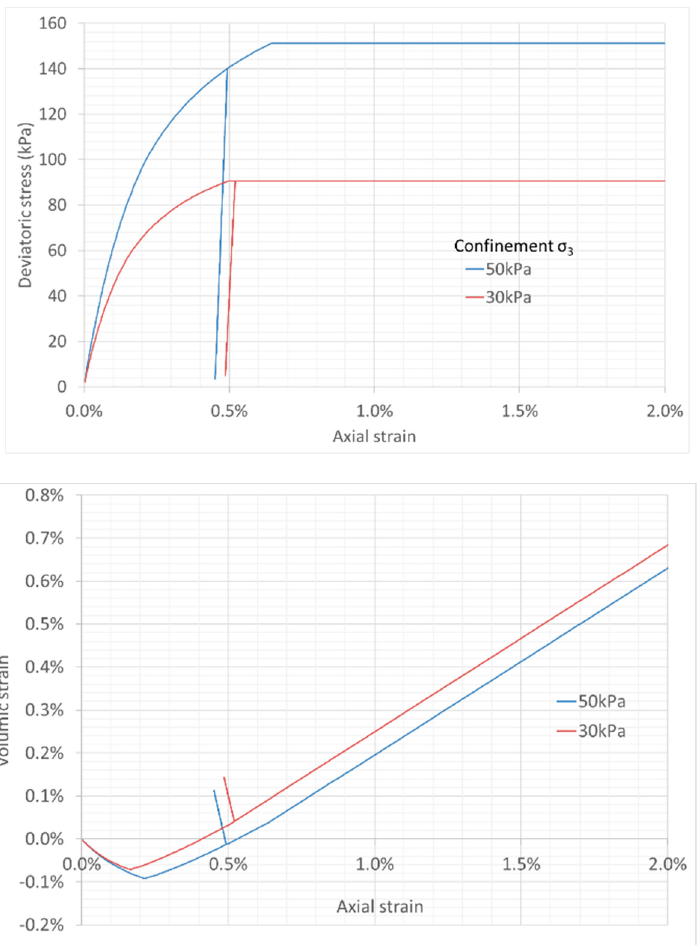
Figure 7. Triaxial numerical test results with CHsoil. Table 2. Parameters of the CHsoil model.